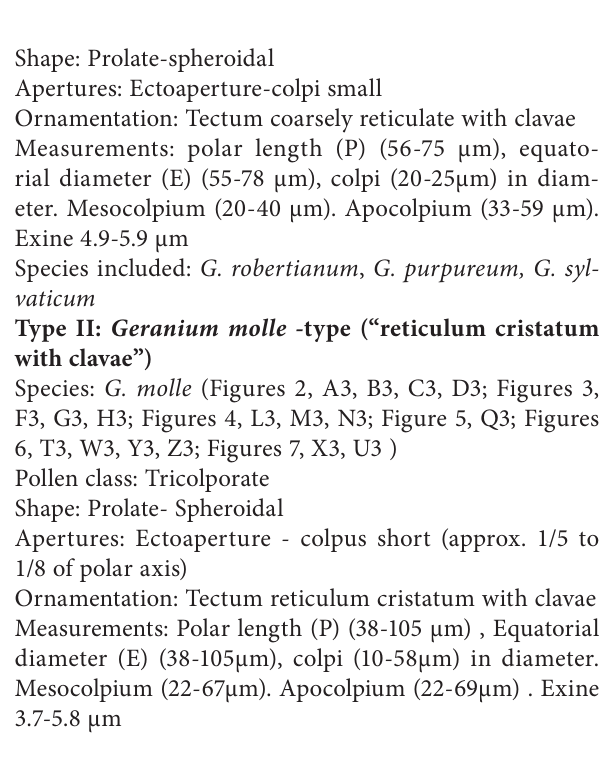
Figure 1. Ward clustering of Geranium species based on observed pollen